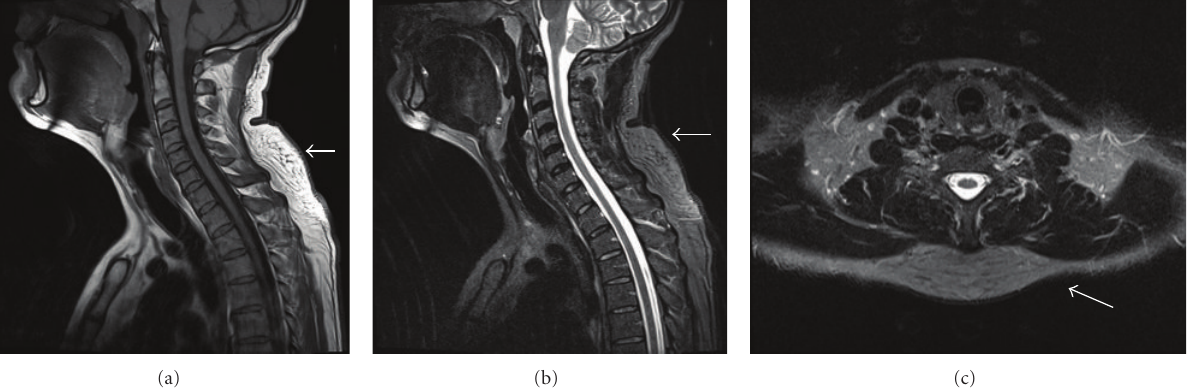
Figure 3: MRI of the neck demonstrates a subcutaneous mass (white arrows) in the interscapular region isointense to surrounding subcutaneous fat on T1-weighted sequence (Figure 3(a) , repetition time/echo time = 451/11 msec) and on fat-suppressed sequence (Figures 3(b) and 3(c), repetition time/echo time = 7090/89 msec). There is absence of a low signal intensity fibrous capsule (Figure 3(c)) typical of a